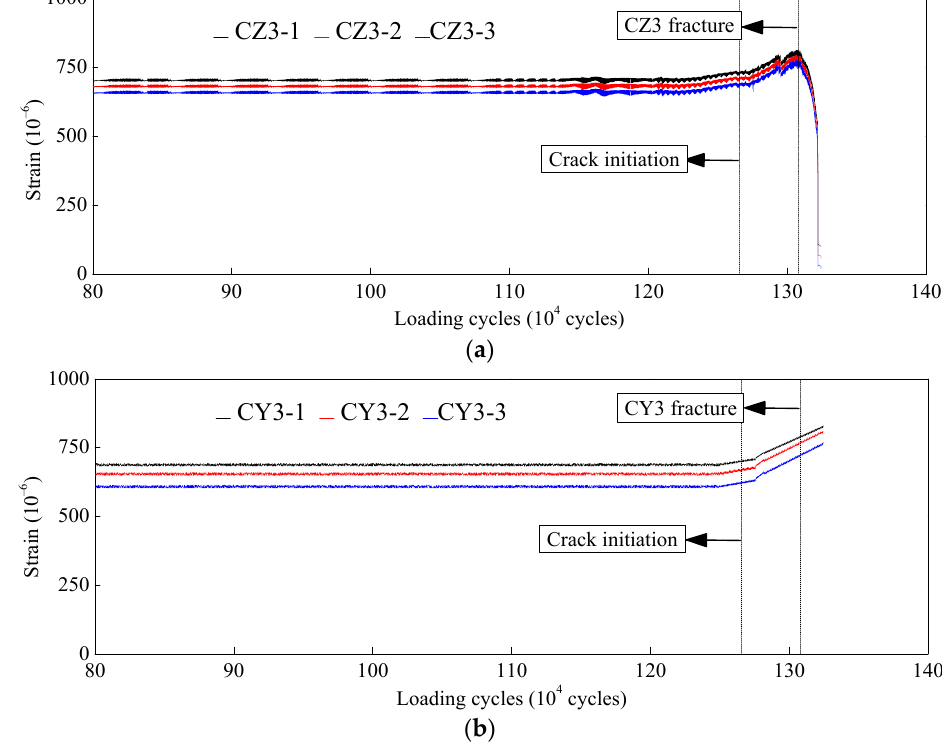
Figure 8. Time histories of dynamic strain: ( a ) CZ3; and ( b ) CY3.